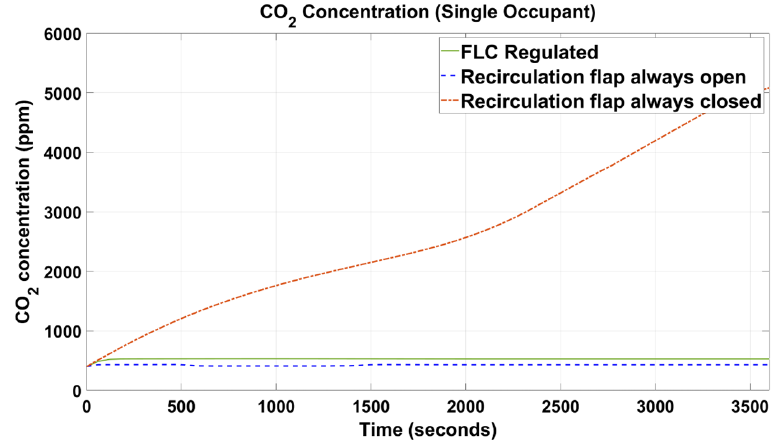
Figure 9. CO 2 concentration of the simulated vehicle cabin with one occupant.